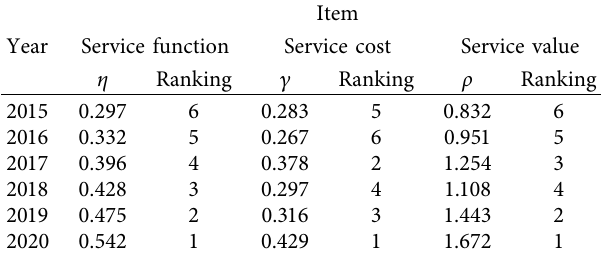
Table 4: Evaluated SSS values of libraries in